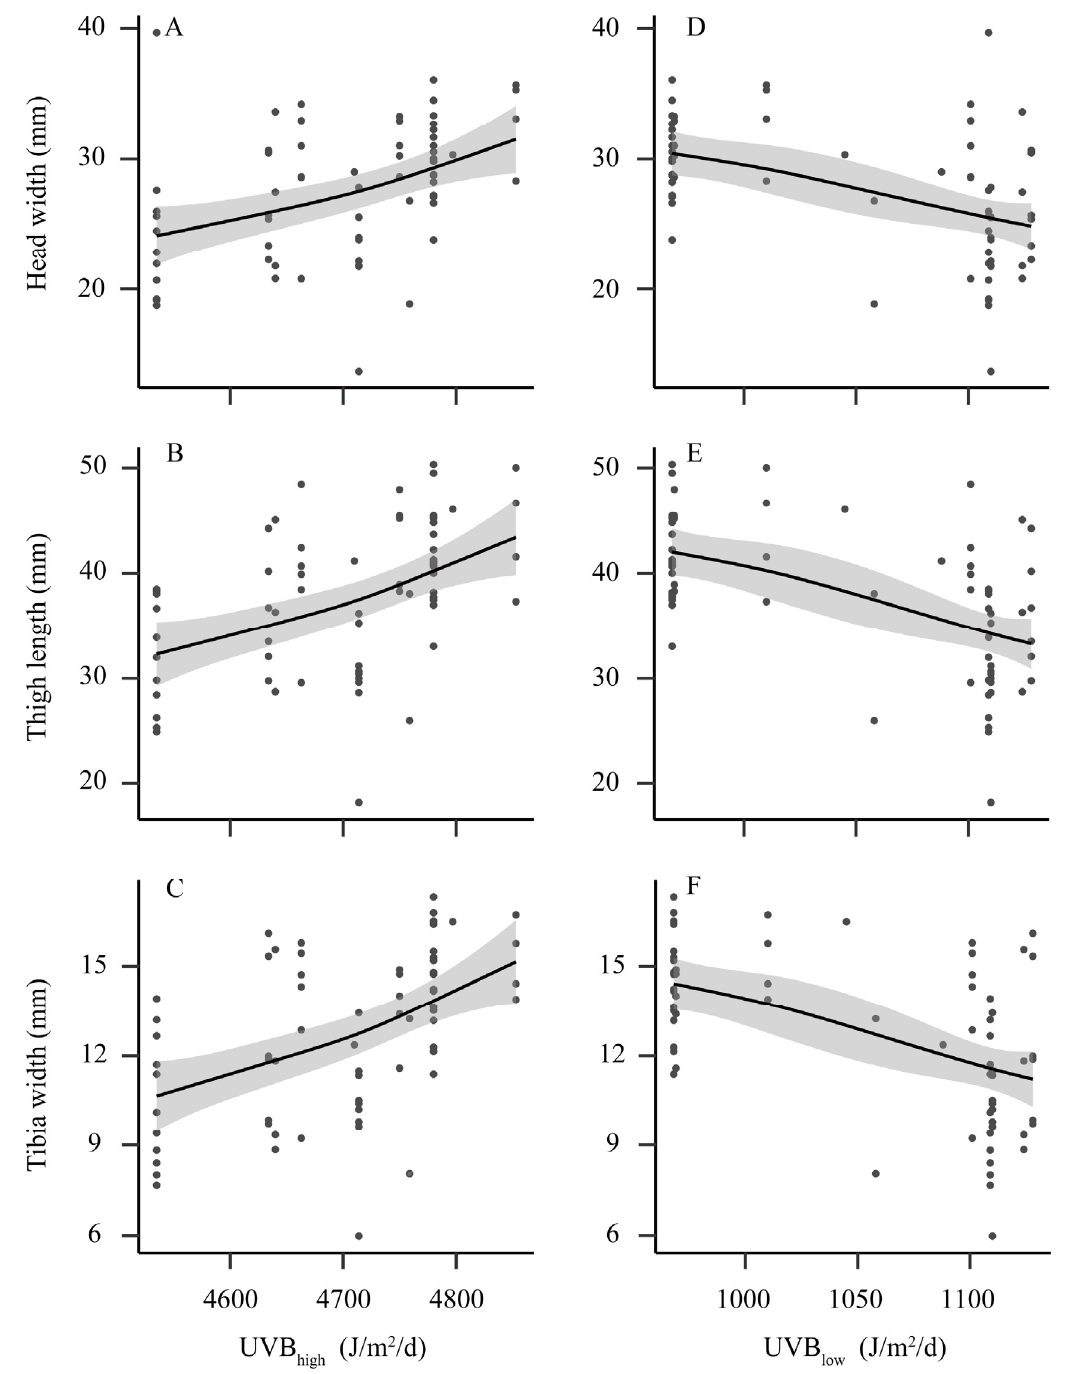
Figure 3. Variation in morphological traits along the gradient of ultraviolet-B (UV-B) radiation. (A–C) the gradient of mean UV-B of the highest month (UVB high ); (D–F) the gradient of mean UV-B of the lowest month (UVB low ). Illustrations are predicted smoothed regression lines with confidence intervals from generalized additive mixed-effects models.